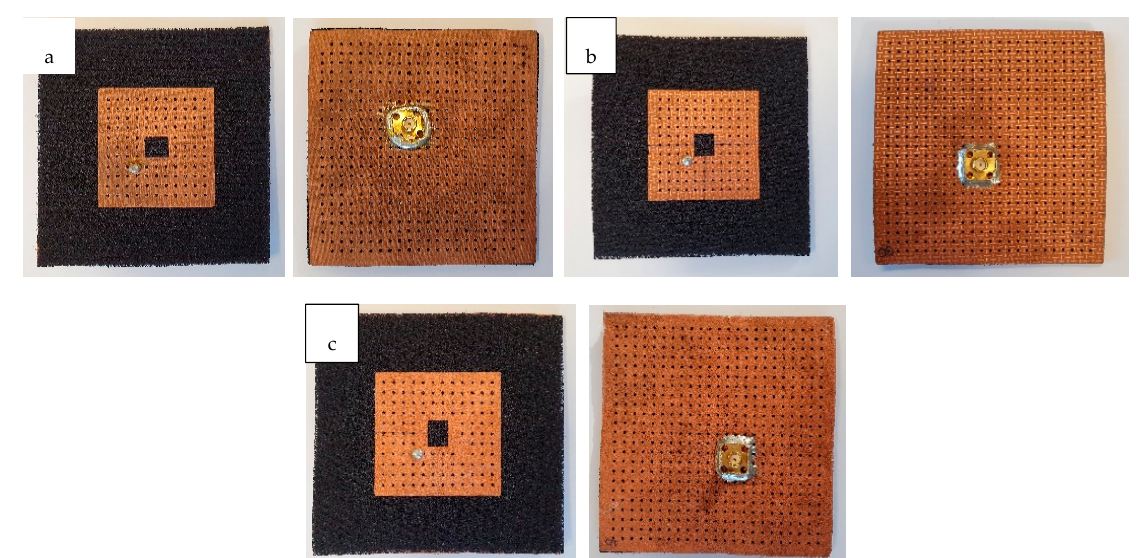
Figure 7. Front side ( left ) and backside antenna ( right ) ( a ) Prag-based perforated RRMPA, ( b ) Kiel-based perforated RRMPA, and ( c ) Koln-based perforated RRMPA.